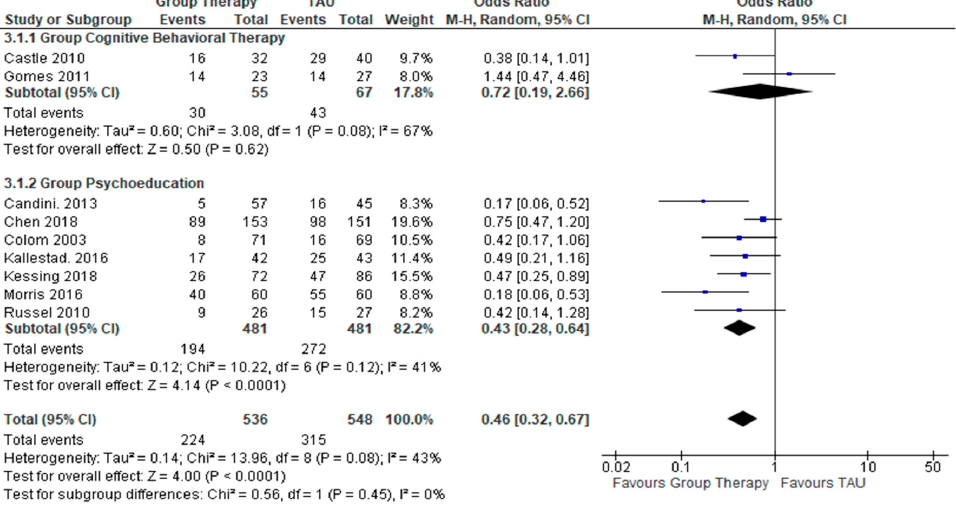
Figure 2. Forest plots for relapse rates after interventions.